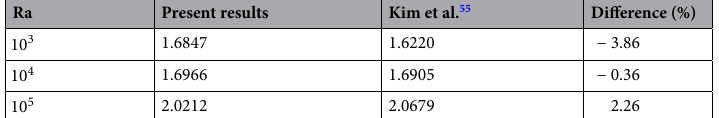
Table 2. Mesh sensitivity at δ D S = 10, φ av = 0.02 .